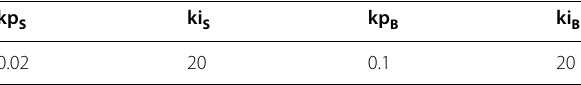
Table 3 The assumed gain values